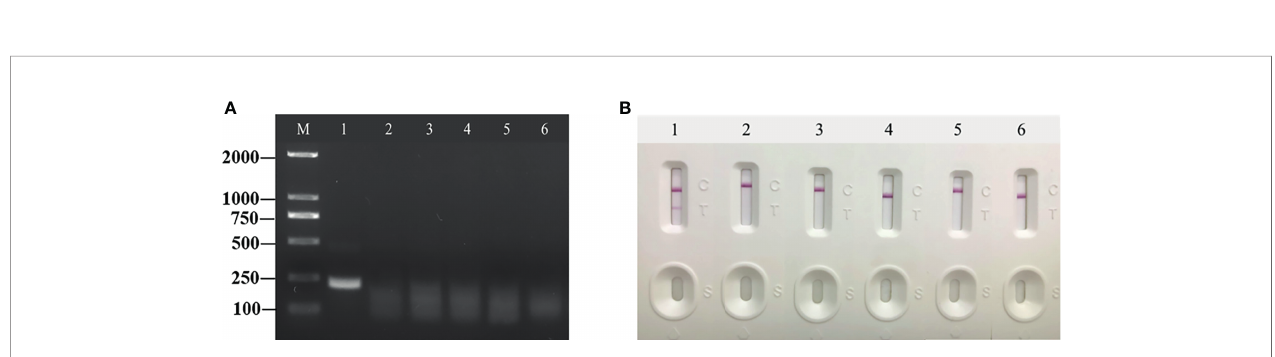
FIGURE 5 | Speci fi city of reverse transcription recombinase-aided ampli fi cation (RT-RAA) and RT-RAA-lateral fl ow dipstick for common porcine diseases. (A) Agarose gel electrophoresis of RT-RAA. M, DL 2000 DNA marker; 1, HCV; 2, HAV; 3, HBV; 4, HIV; 5, syphilis; and 6, HPV. (B) RT-RAA-LFA visual readout. 1, HCV; 2, HAV; 3, HBV; 4, HIV; 5, syphilis; and 6,